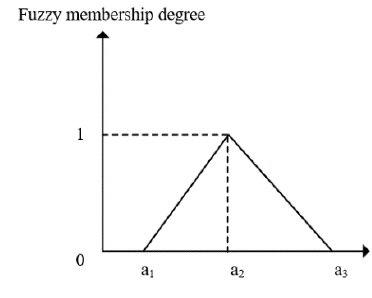
Figure 2. A triangular fuzzy number.